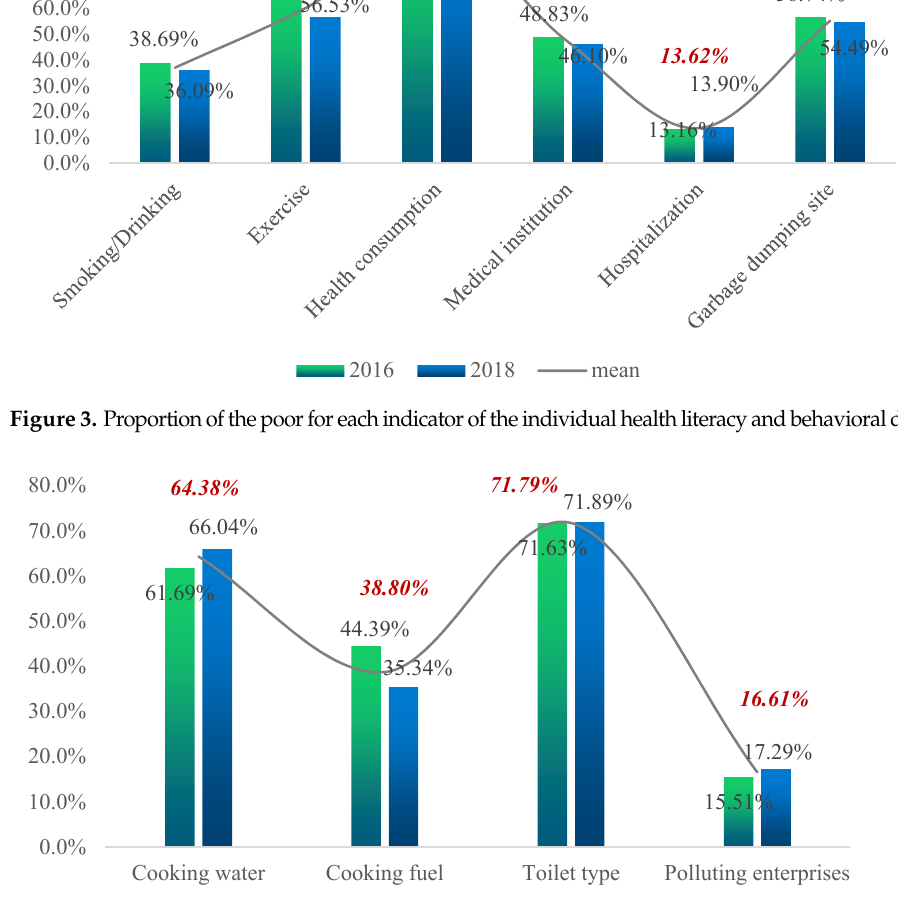
Figure 5. Proportion of the poor for each indicator of the health service and security rights dimen- sion. Figure 2 shows that, from the two-year mean, the proportion of the population that had “per capita annual net income of households” below the relative poverty line was the highest, at 59.86%. The proportion of the population suffering from “chronic diseases” was the lowest, at 18.37%. By comparing the two-year data, one can see that, except for the increase in the proportion of health poverty people in “SRH”, all other indicators showed a downward trend. Figure 3 shows that, from the two-year mean, the proportion of health poverty people in the indicator of “health consumption” was the highest, at 90.27%. The proportion of health poverty people in the indicator of “hospitalization or not” was the lowest, at 13.62%. The other indicators were roughly the same. By comparing the two-year data, one can see that, except for the slight increase in the proportion of the health poverty popula- tion in the indicator of “hospitalization or not”, the proportions of the other indicators decreased significantly. Figure 4 shows that, from the two-year mean, the proportion of health poverty people in the indicator of “toilet type” was the highest, at 71.79%. The proportion of “high-pollu- tion enterprises” was the lowest, at 16.61%. By comparing the two-year data, one can see